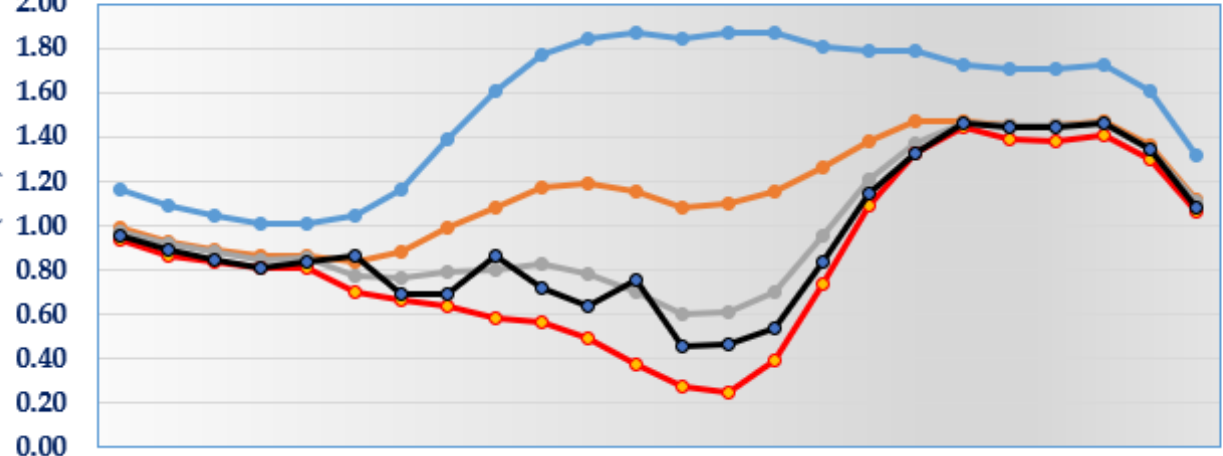
Figure 14. Hourly power losses with varying the number of installed devices compared to the initial case for IEEE 69-feeder.